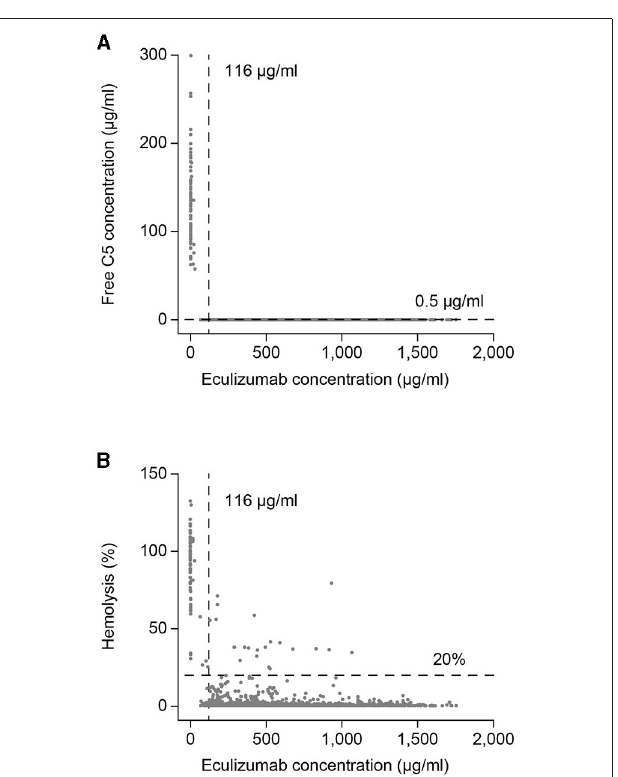
FIGURE 3 | concentrations below 0.5 µ g/ml (dashed line) indicate complete terminal complement inhibition. No free C5 data were available for one patient. (B) Mean (95% CI) percent in vitro complement-mediated hemolytic activity of serum samples. Hemolysis values above 20% (dashed line) indicate incomplete inhibition of hemolysis. No hemolysis data were available for one patient. For both analyses, samples were taken before and after eculizumab infusion (i.e., at eculizumab serum trough and peak concentrations, respectively); samples taken before and after infusion in patients receiving placebo are shown for comparison. C5, complement protein 5; CI, confidence interval. a Samples taken 5–90min before infusion. b Samples taken 60min after the completion of infusion. Data are plotted for timepoints when samples were available for ≥ 10 patients. The numbers reported below the graphs are the numbers of patients for whom samples were tested at that timepoint.